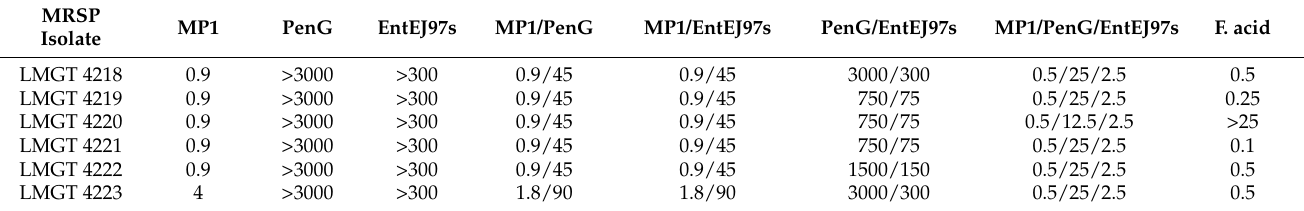
Table 3. MIC 50 values ( µ g/mL) for MP1, PenG and EntEJs against six MRSP biofilms, assessed individually and in combination (average of triplicate tests). Challenged biofilms were incubated with antimicrobials for 24 h at 37 ◦ C (see Section 4). Fusidic acid (F. acid) was used here for